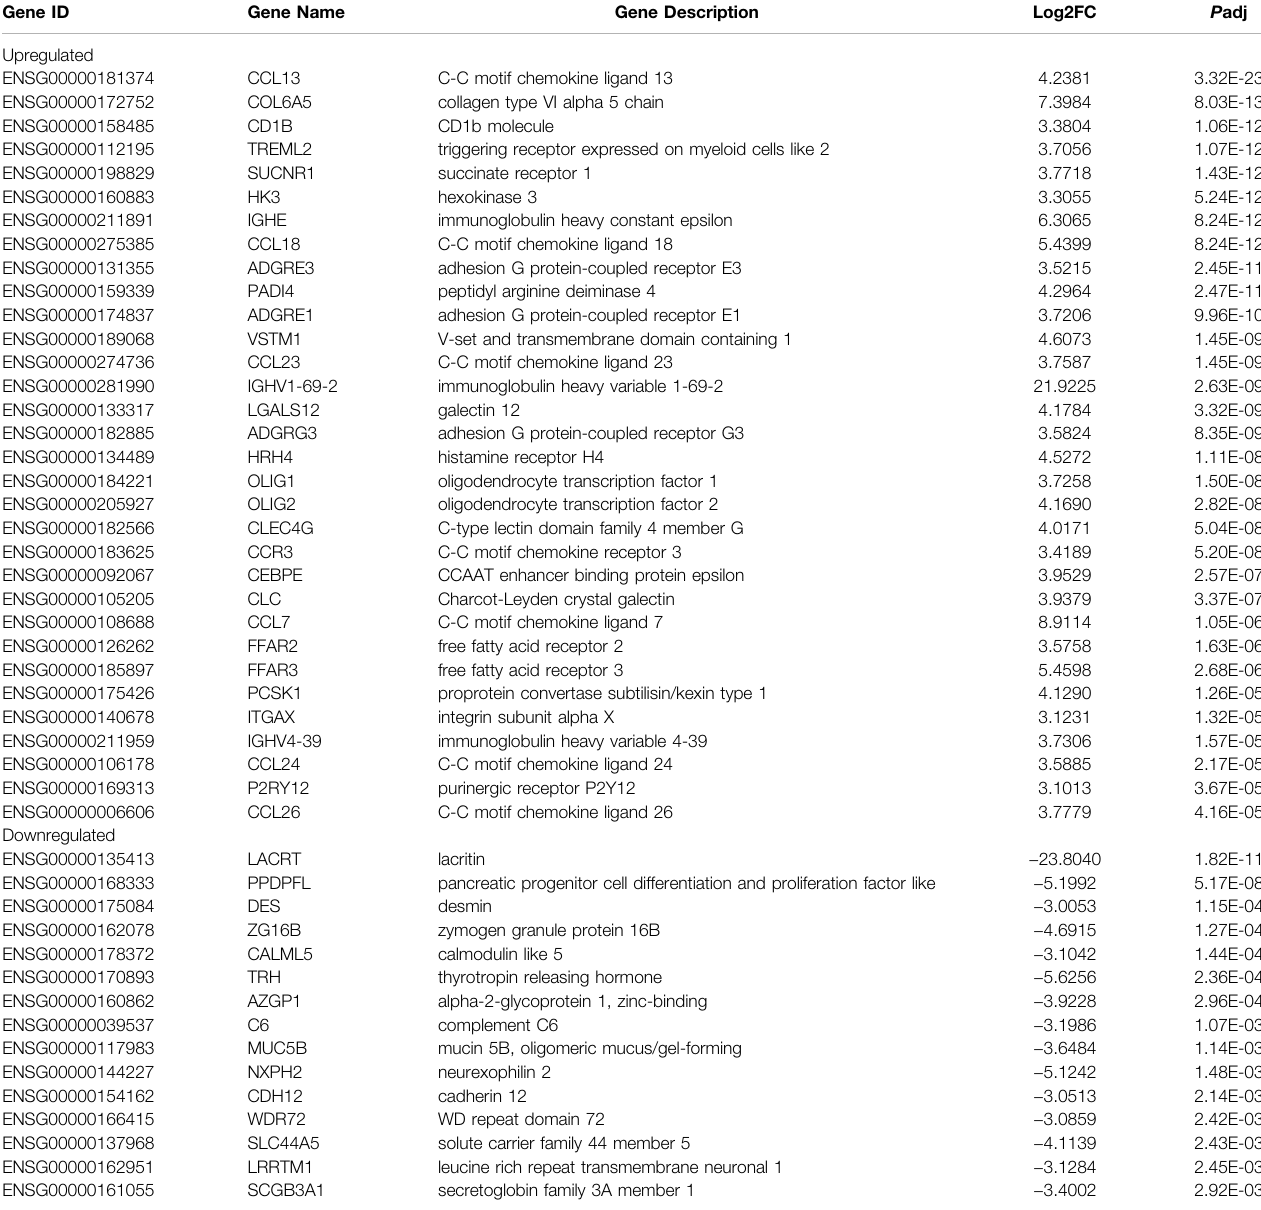
TABLE 2 | Top upregulated and downregulated protein-coding genes in the Responder group compared to the Non-responder group at baseline. Gene